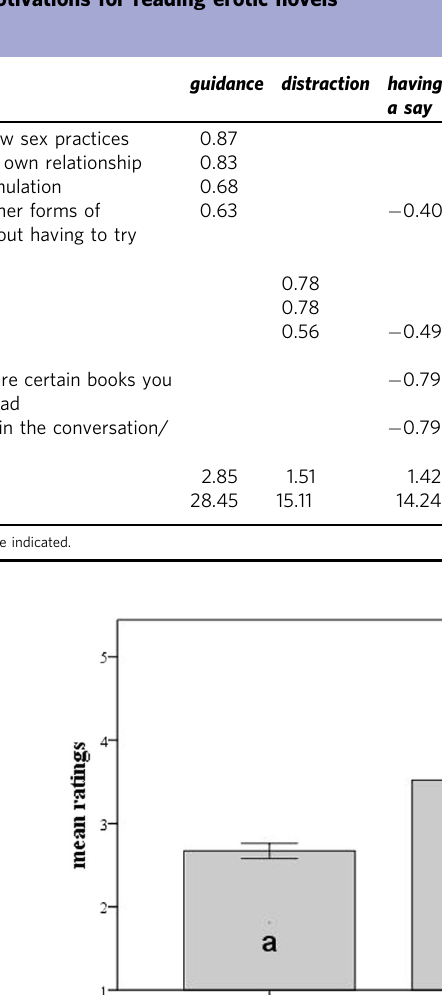
Table 5 Component loadings for a principle components analysis (PCA) with oblimin rotation of the items describing participants ’ motivations for reading erotic novels